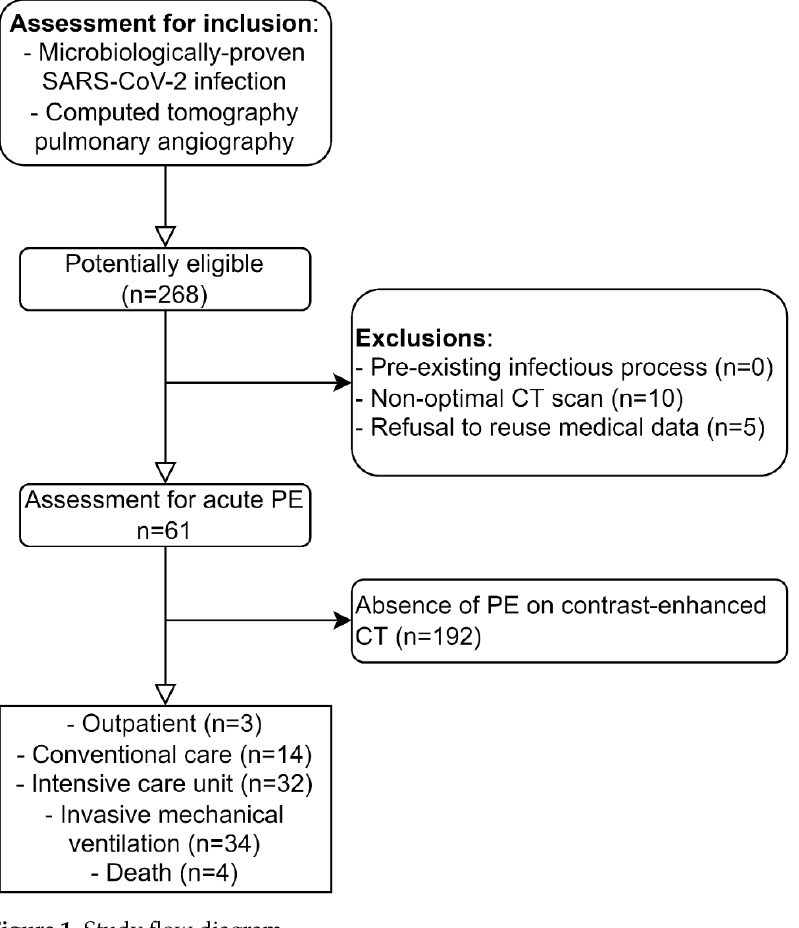
Figure 1. Study flow